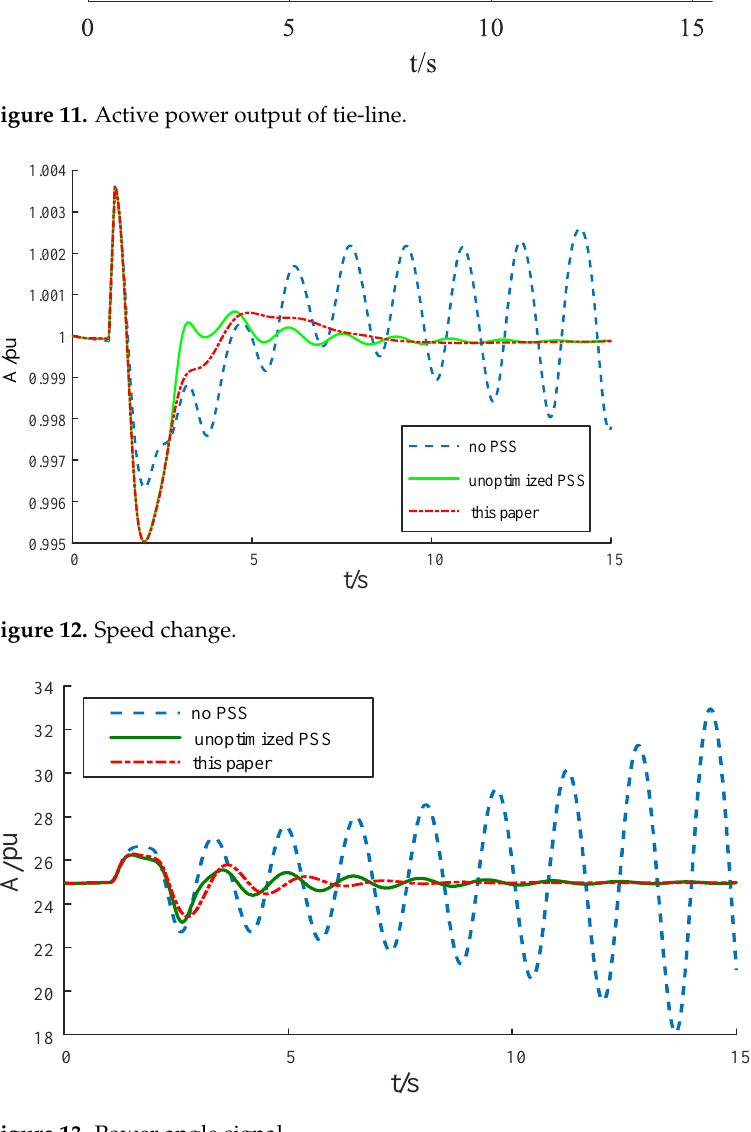
Figure 13. Power angle signal.